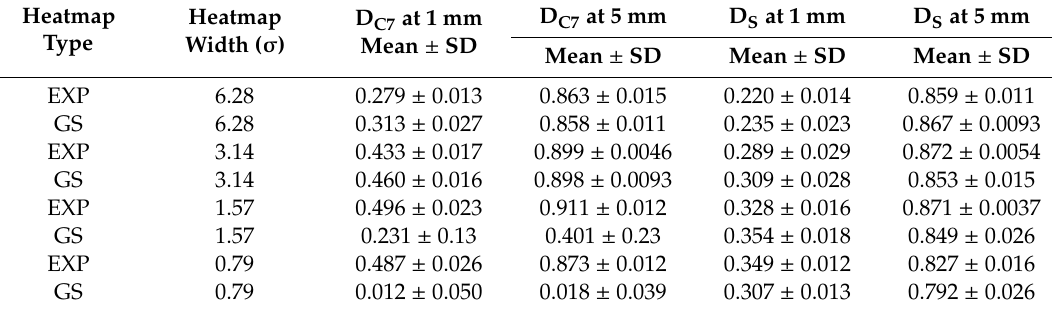
Table 3. The 1-mm and 5-mm detection rates of models trained using di ff erent hyperparameter settings. Mean ± standard deviation (SD) of the detection rates were obtained following the procedure of 10-fold cross-validation.